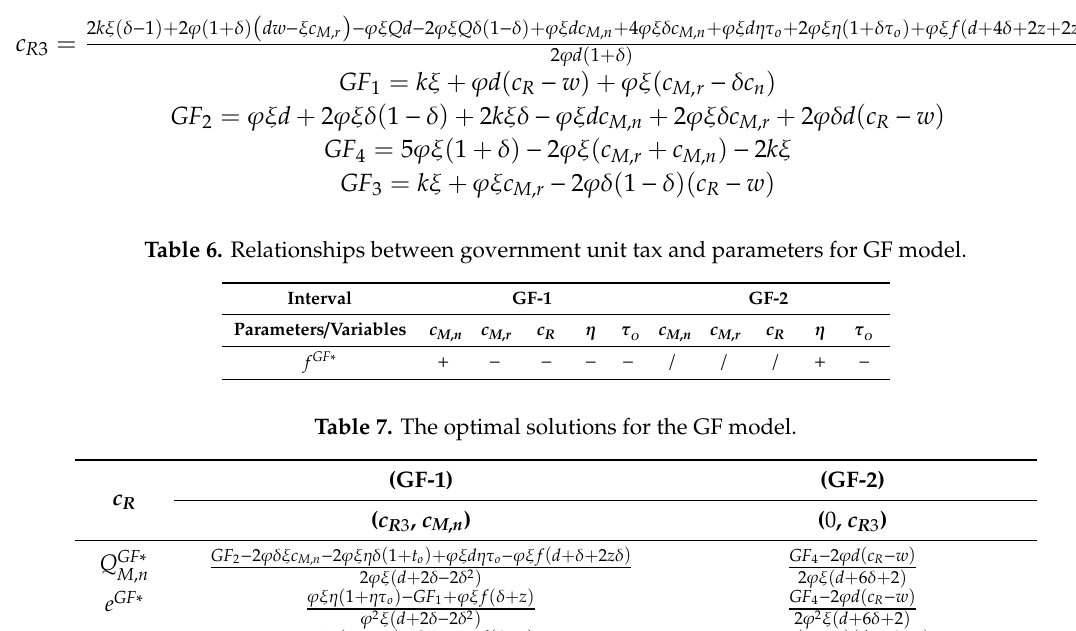
Table 7 . By analyzing the solution results, the relationships between each decision variable and the parameters are obtained. The results are shown in Table 8.